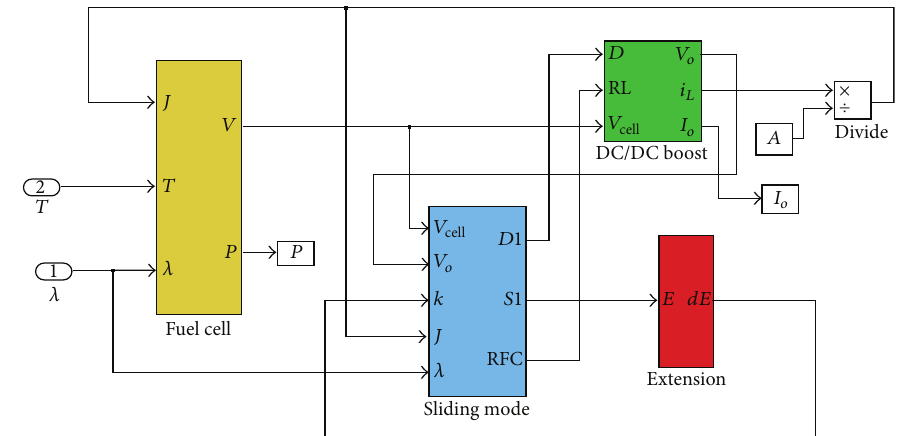
Figure 5: Integrated Simulink model of FC and ESM control system.